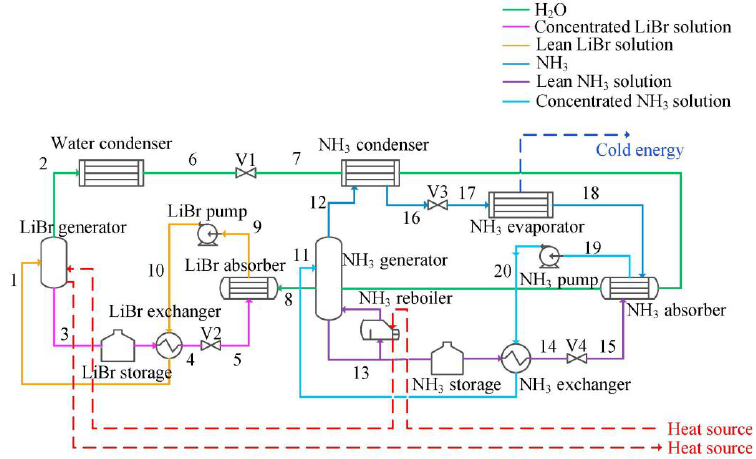
Figure 4. The schematic diagram of CARS [55]. Reproduced with permission from [Elsevier], Elsevier, 2020.